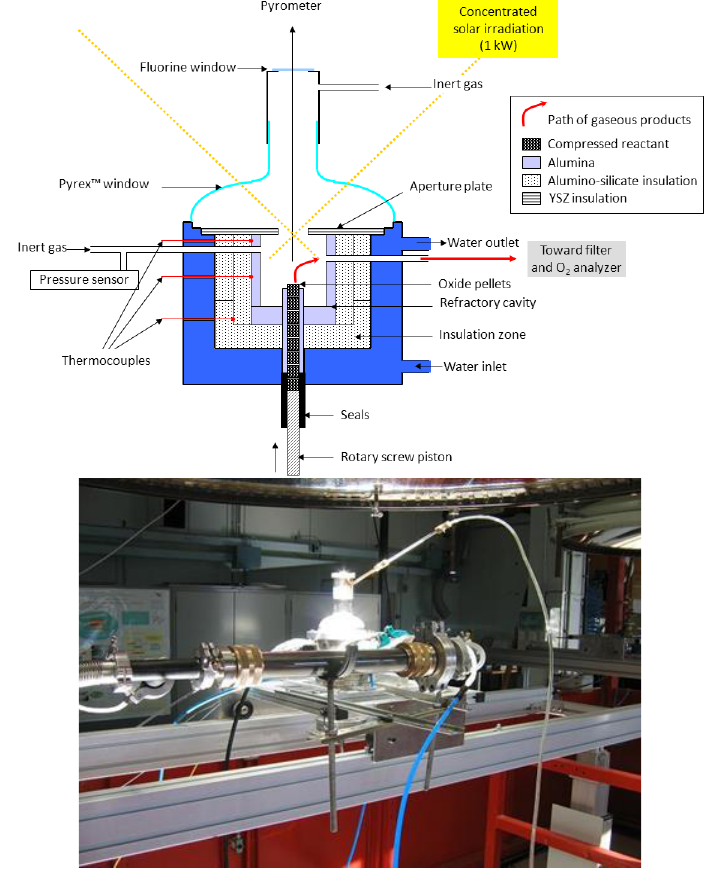
Figure 13. Solar reactor prototype designed and tested for the thermal dissociation of volatile oxides (ZnO, SnO 2 ) with continuous reactant injection in the form of compressed pellets.